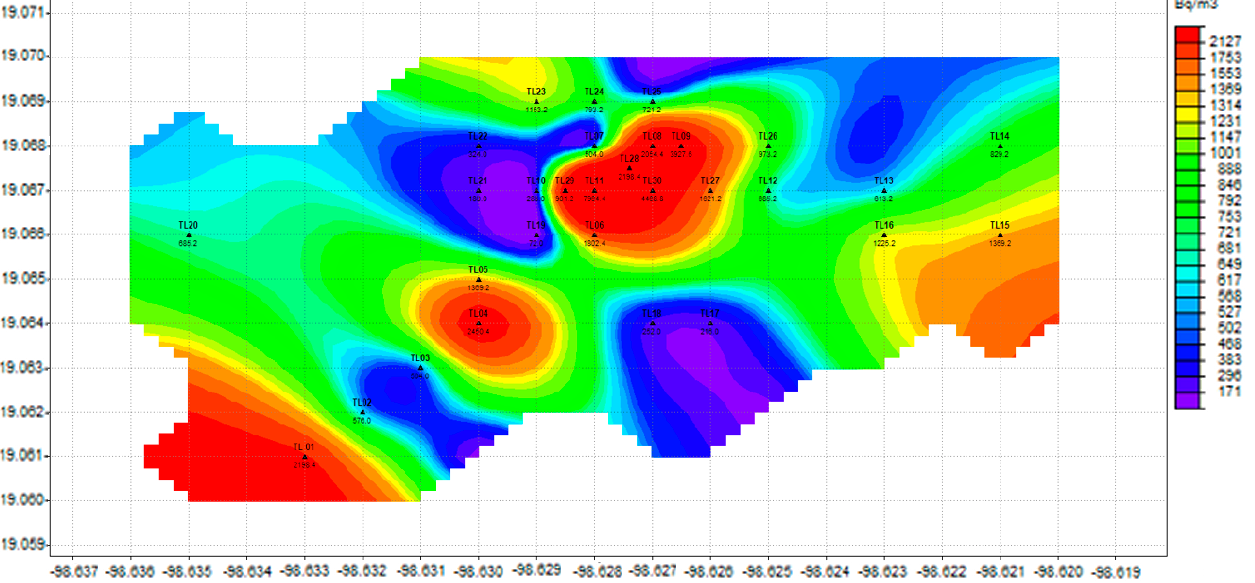
Figure 4. Spatial distribution of the radon concentration in Tlamacas Mountain, April–May 2010. The top of Tlamacas Mountain is approximately in the center of the map. Black triangles denote measurement stations, accompanied by station numbers and measured radon values in Bq/m 3 .